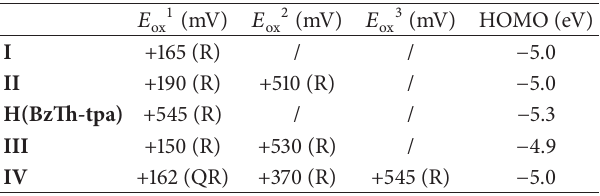
Table 1: Cyclic voltammetry data relative to complexes I – IV and 𝑛 , 𝑛 = 1, 2, 3 , refer to the oxidation waves recorded H(BzTh-tpa) . 𝐸 ox on increasing potential. Estimated